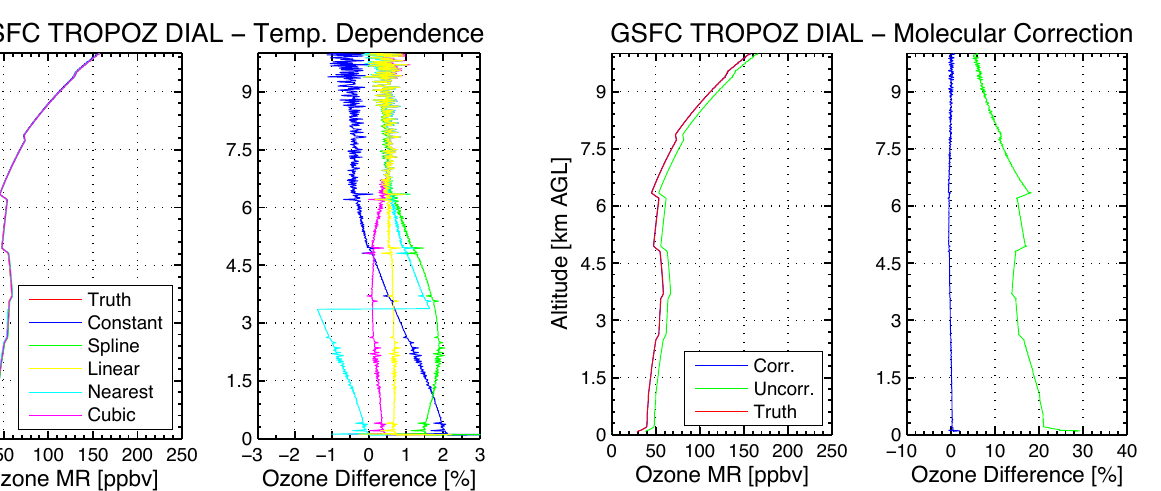
Figure 3. The left panel shows the retrieved ozone mixing ratio from the varying TROPOZ interpolations of the temperature de- pendence of ozone absorption cross sections as compared to the known ozone profile used in the simulated lidar return signal.The right panel shows the percent difference from the known profile and retrieved profile.